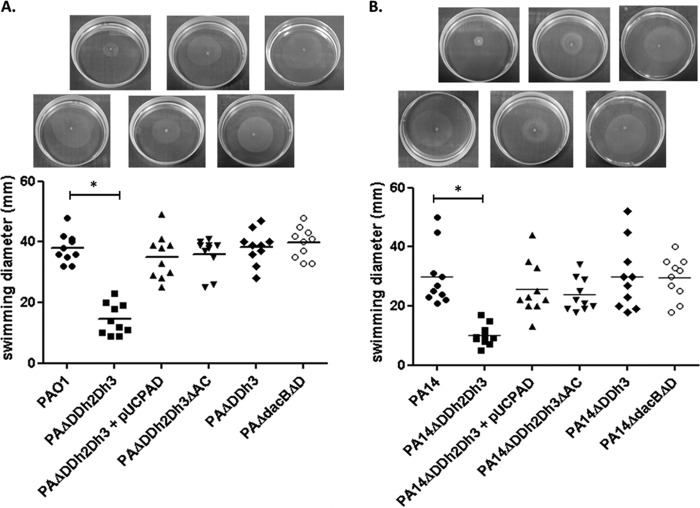
Swimming motility of strains PAO1 (A) and PA14 (B) and mutants derived from the two strains. Colonies were inoculated as described in Materials and Methods. The diameters of the motility areas of 10 different colonies per strain were measured. Each symbol represents the value for one colony, and the mean value for the 10 colonies is indicated by the short black bar. The values (means) that are significantly different (P < 0.0001 by Student’s t test) from the mean value for the wild-type strain are shown by a bar and asterisk. The rest of the single and double ampD mutants of both PAO1 and PA14 showed wild-type swimming motility levels (not shown). The pictures above the graph show representative images of the corresponding strains.